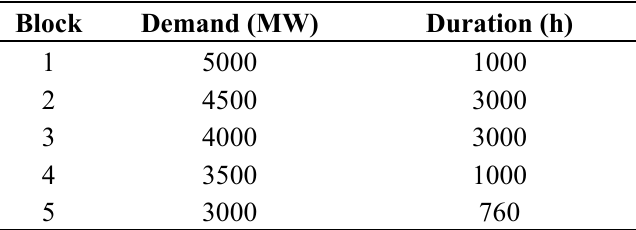
Table 2. Parameters of load